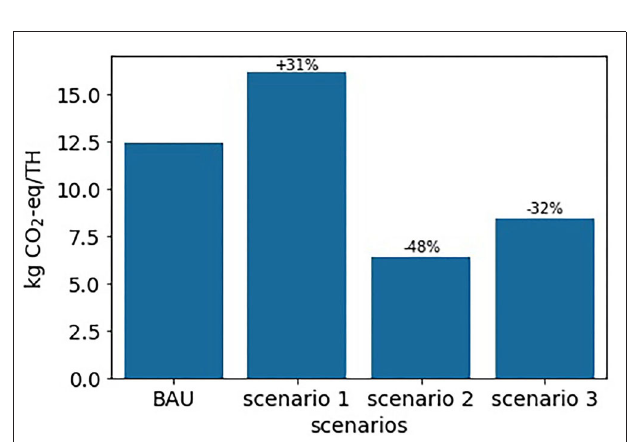
FIGURE 6 | Global Warming impact in kg CO 2 -eq/TH (Terahash) for different Bitcoin mining scenarios. BAU: Business as usual scenario (linear growth): Scenario 1: location-sensitive scenario. Scenario 2: equipment-sensitive scenario. Scenario 3: location- and equipment-sensitive